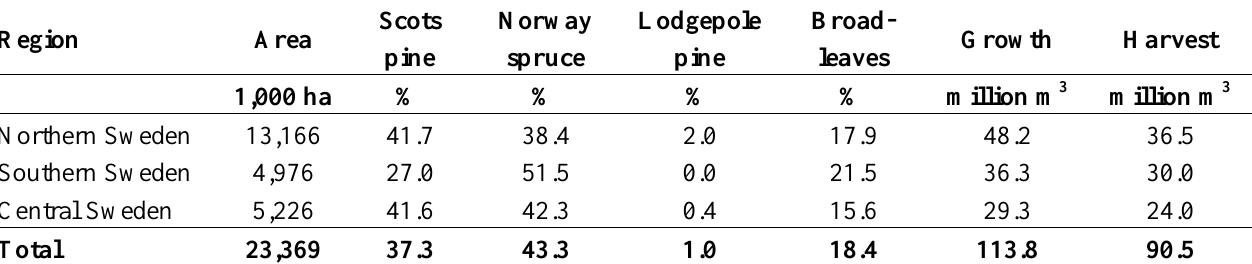
Table 1. Forest area, tree species composition, stem volume growth, and harvested volume for different parts of Sweden at the start of the simulation